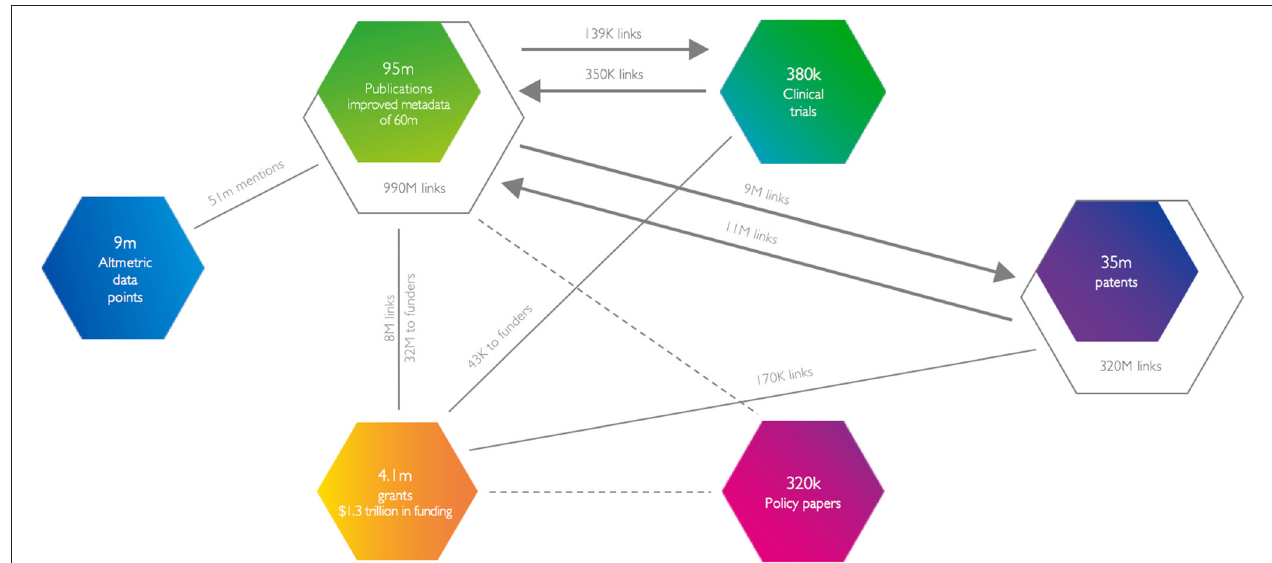
FIGURE 2 | In the launch version of Dimensions, the database contained 90 million publications (of which 50 million were enhanced using a full-text version) to create 873 million citation links. In addition, grants information from more than 250 funders provided 3.7 million grant objects representing 1.3 trillion US dollars of funding and, by mining acknowledgments sections and use of PubMed data, resulted in 8 million links to grants and 32 million funder acknowledgments. The IFI claims patent database was added with 34 million patents and 320 million citations within those patents with a further 11 million citations to scholarly articles and 9 million citations from scholarly articles. Altmetric provided information on attention concerning 9 million articles. Clinical trials data represented a smaller dataset with 380,000 records and links to 350,000 papers, from 139,000 papers and 43,000 grant acknowledgments.